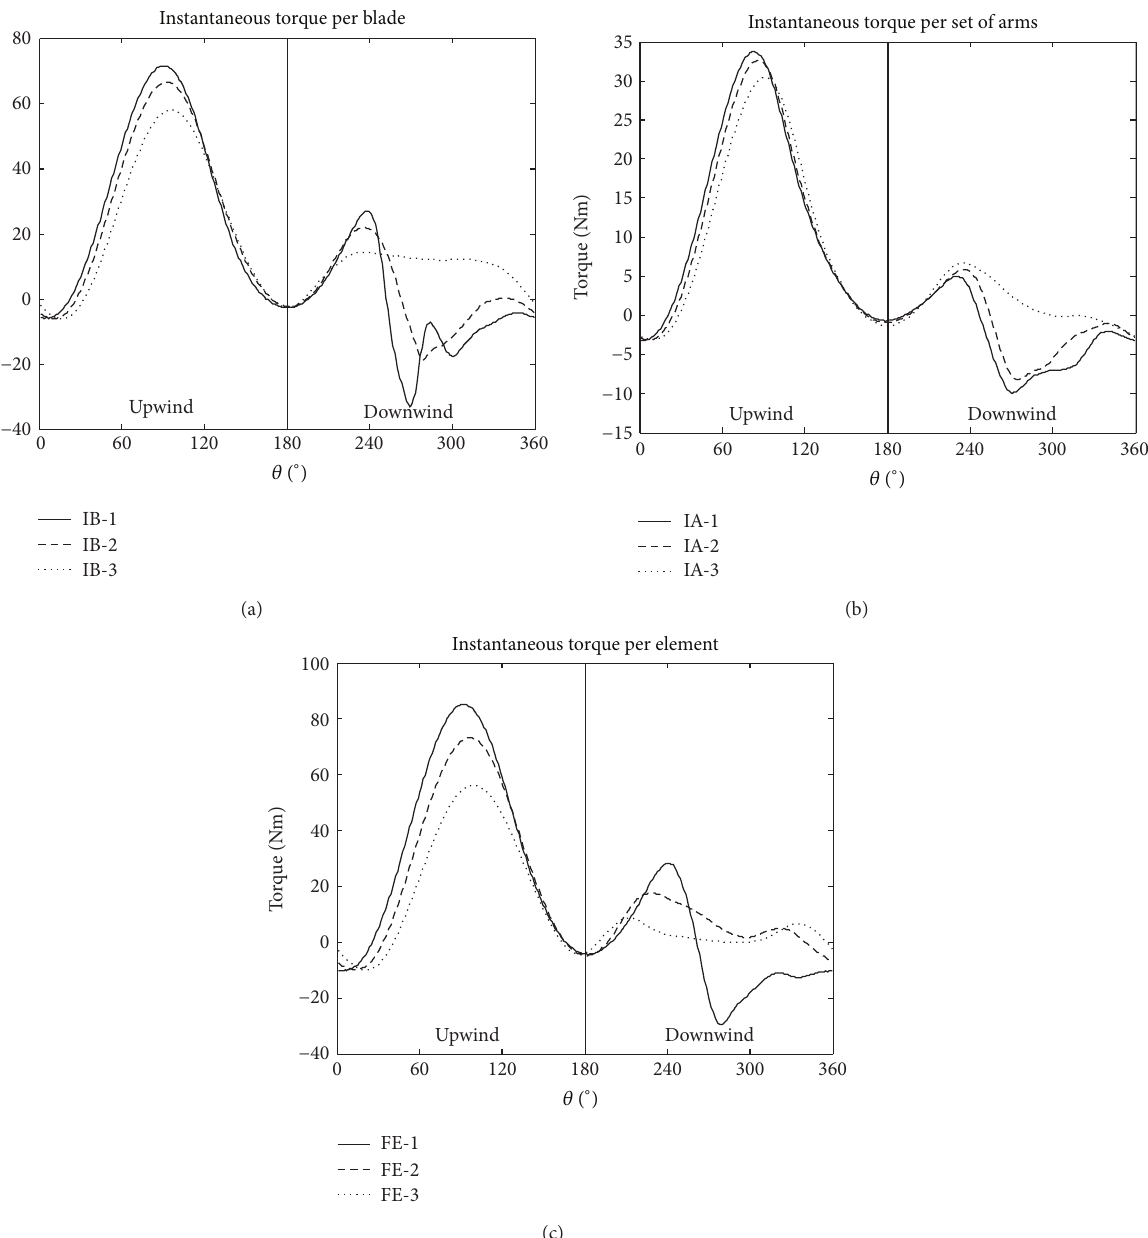
Figure 12: (a) Instantaneous torque per blade (generated by a single isolated blade) when a different number of isolated blades are present in the simulation. (b) Instantaneous torque per set of arms (generated by a single isolated set of arms) when a different number of isolated set of arms are present in the simulation. (c) Instantaneous torque per element (generated by a single full element) when a different number of full elements are present in the